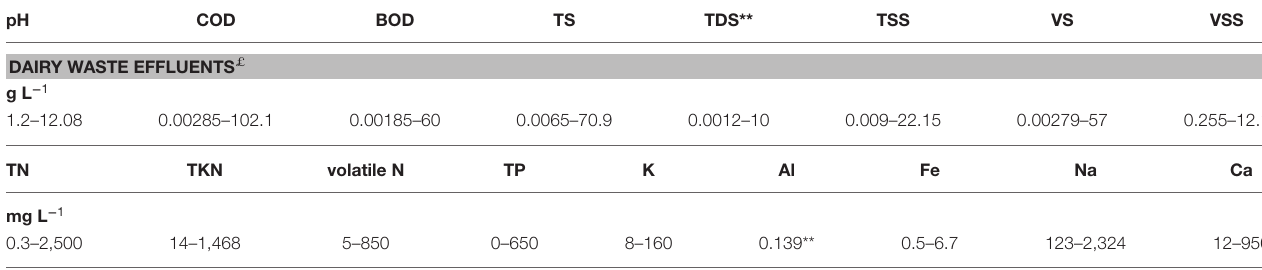
TABLE 2 | Physicochemical characteristics of dairy waste effluents* (Danalewich et al., 1998; Omil et al., 2003; Demirel et al., 2005; Byrne, 2011; Carvalho et al., 2013; Karadag et al., 2015; Kolev Slavov, 2017; Verma and Singh, 2017; Goli et al., 2019; Ferreira et al., 2021; Sivaprakasam and Balaji, 2021 ). pH COD BOD TS TDS** TSS VS